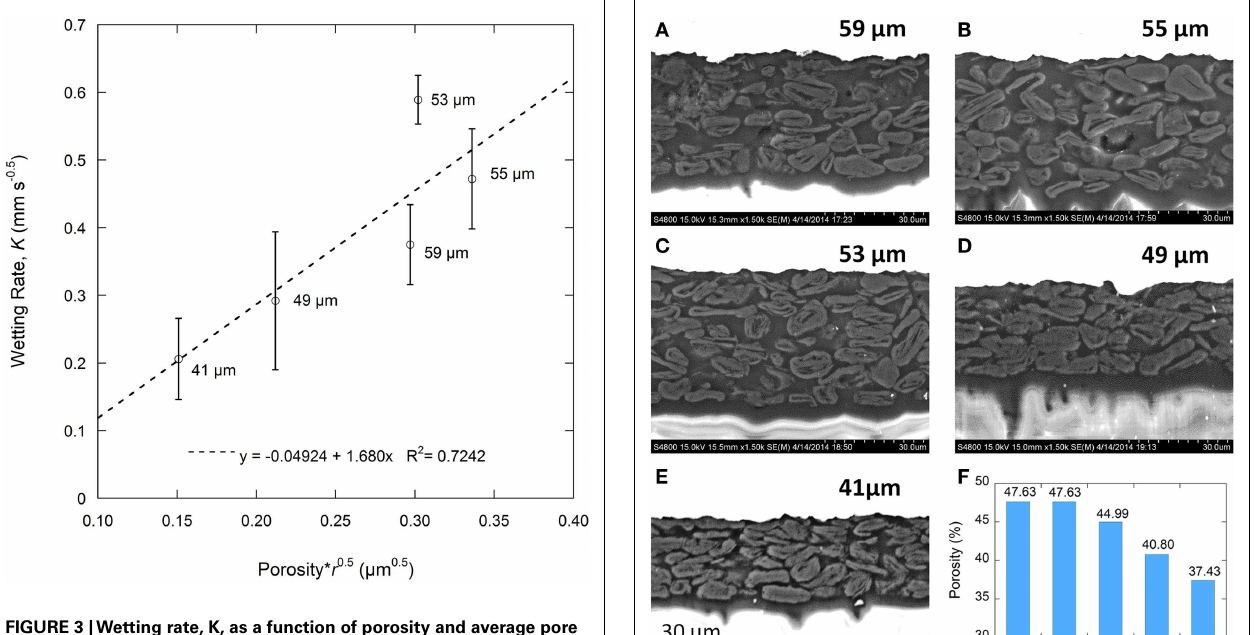
FIGURE 3 |Wetting rate, K, as a function of porosity and average pore radius according to the Lucas–Washburn Eq. 1b . Average pore radius ( r ) is based on the average pore diameter as measured by MIP.